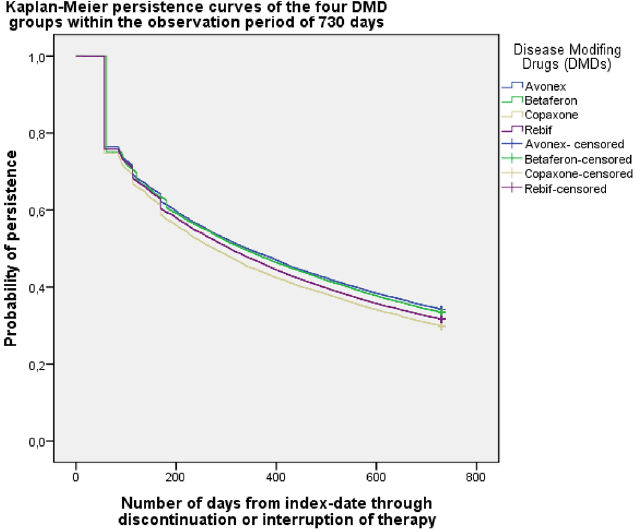
Fig 6. Main analysis: Kaplan-Meier persistence curves of the 4 DMD groups within the observation period of 730 days. First day of non-persistence in relation to the index date.